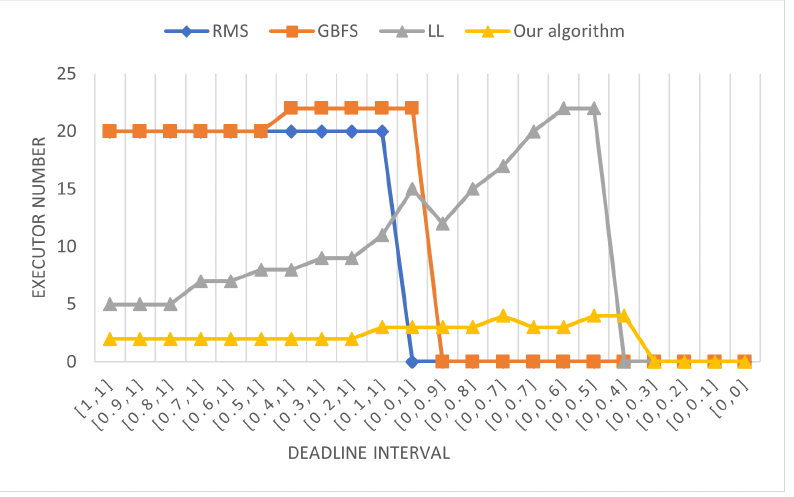
Figure 7. Executor number vs.